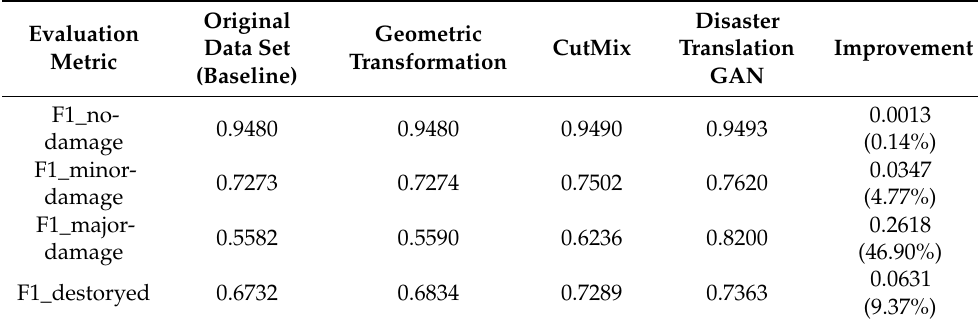
Table 8. Effect of data augmentation by disaster translation GAN.